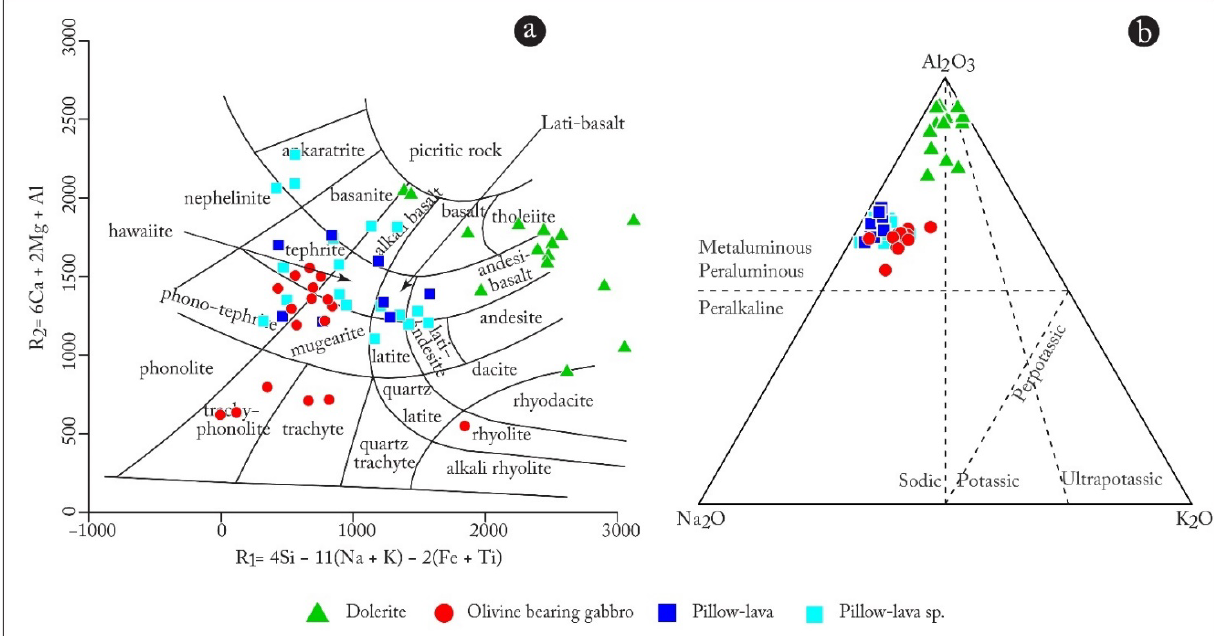
Figure 19. ( a ) R1-R2 [63] and ( b ) Na 2 O-Al 2 O 3 -K 2 O (molar) diagrams [64].